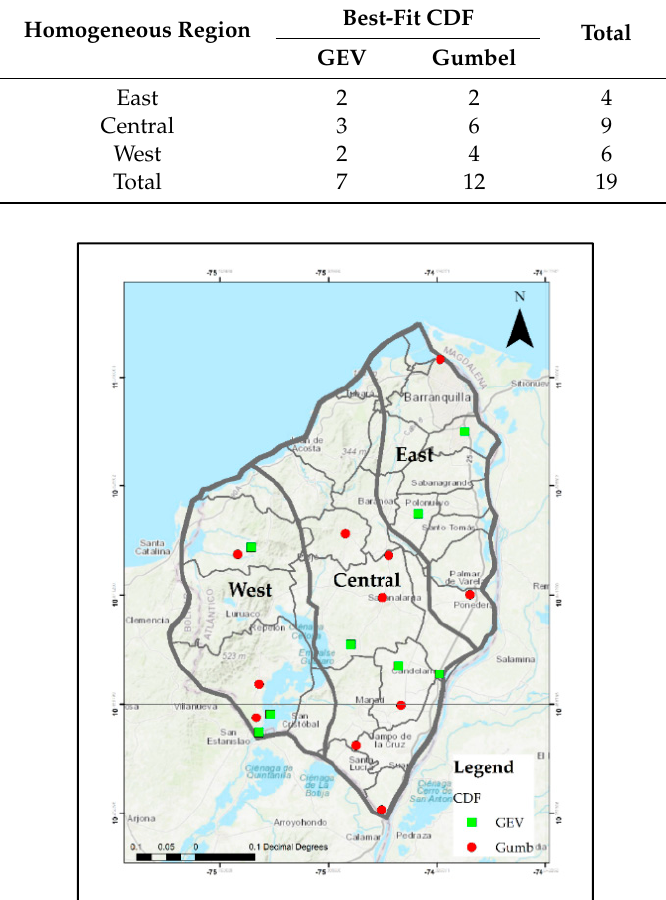
Table 7. Best cumulative distribution function (CDF) per homogeneous zone. GEV—generalized extreme value.